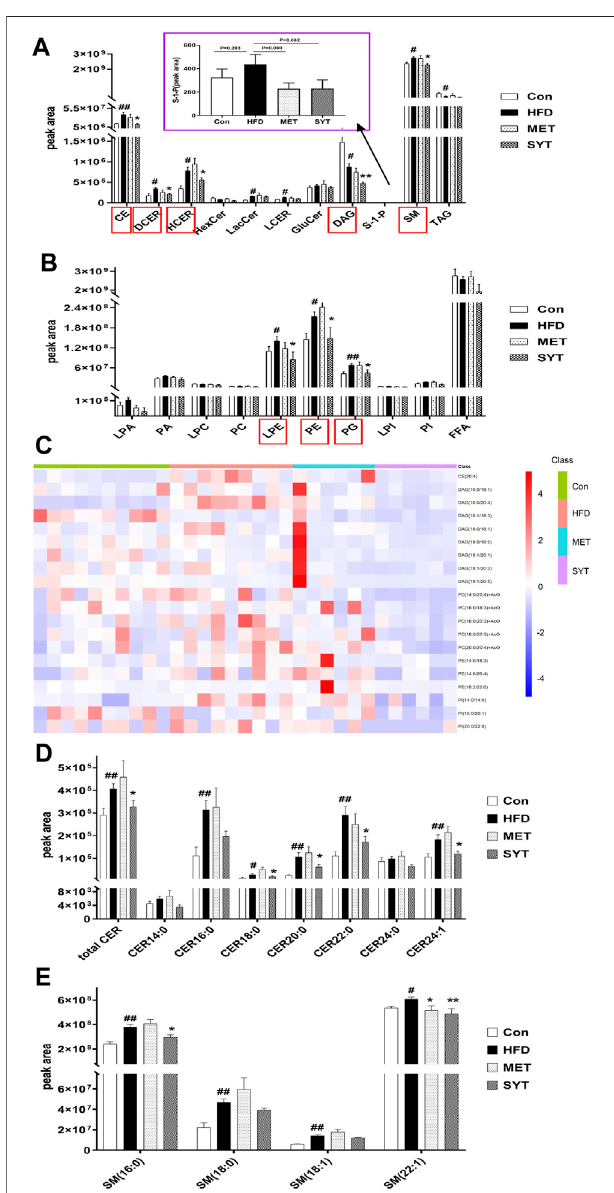
FIGURE 5 | SYT improves serum lipid metabolism in HFD mice by lipidomics analysis based on UHPLC-MS. The intensity ofdifferent serum lipid compositions in positive ion mode (A) . The intensity of different serum lipid compositionsinnegativeionmode (B) .Heatmap ofTOP20signi fi cantly differential lipid species between SYT group and HFD group (C) . Alterations in serum ceramide (Cer) compositions (D) . Alterations in serum sphingomyelin (SM) compositions (E) . # p < 0.05, ## p < 0.01 compared with Con group; * p < 0.05, ** p < 0.01 compared with HFD group.